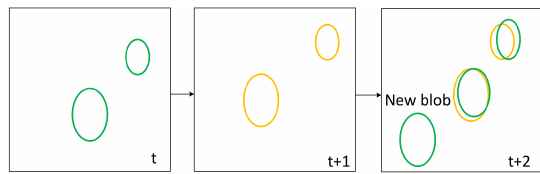
Figure 6. New-object identification. Two blobs (green) are detected in frame t . In frame t + 1, two blobs (yellow) are tracked. Then, a blob (green) is classified as new blob in frame t + 2, which will be added to tracker.